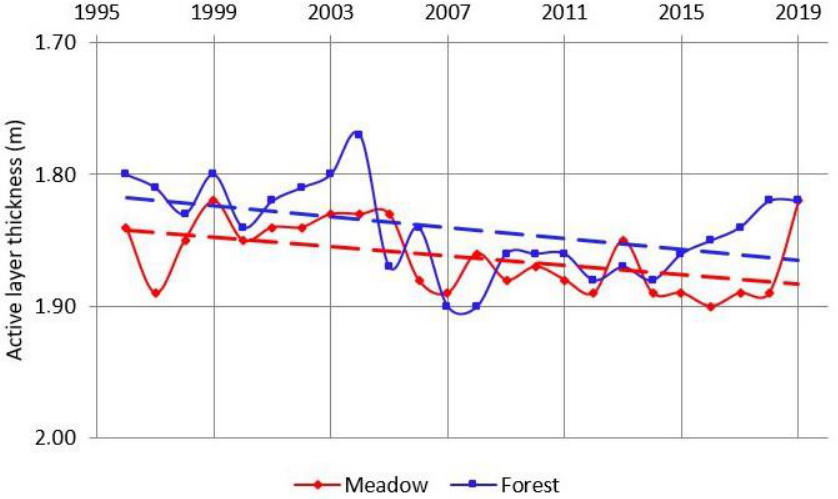
Figure 13. Long-term variability in the active layer’s thickness and trends in the experimental plots of the Tuymaada Station.